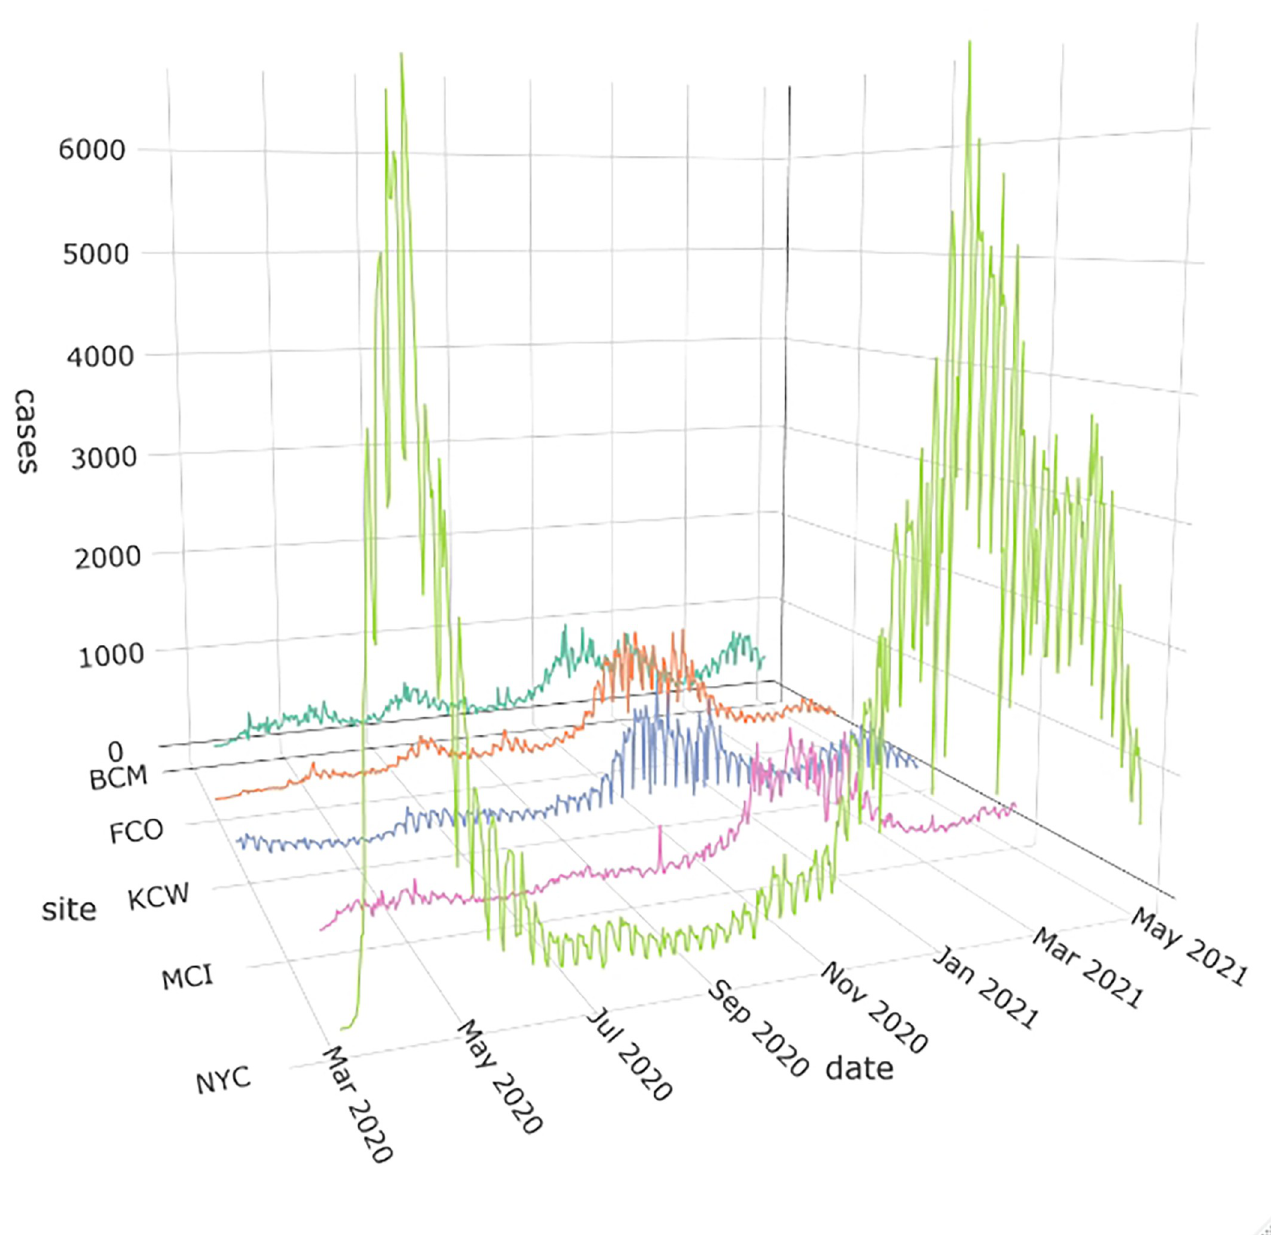
Fig 2. COVID-19 cases reported at the study sites over the course of the study period. NYC: New York City; MCI: Marion County, Indiana (including Indianapolis); BCM: Baltimore County, Maryland (including Baltimore), Franklin County, Ohio (including Columbus), KCW: King County, Washington (including